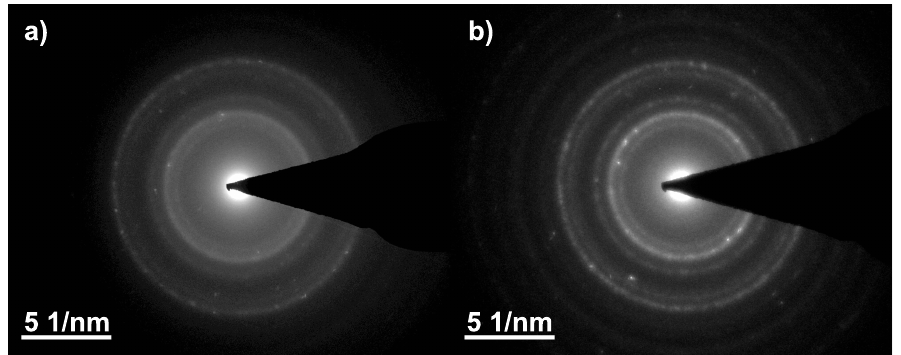
Figure 5. The selective area electron diffraction patterns for ( a ) 50kGy and ( b ) 200kGy irradiation dose show an increasing sharpness of the rings for increasing irradiation doses, indicating a higher crystallinity of the